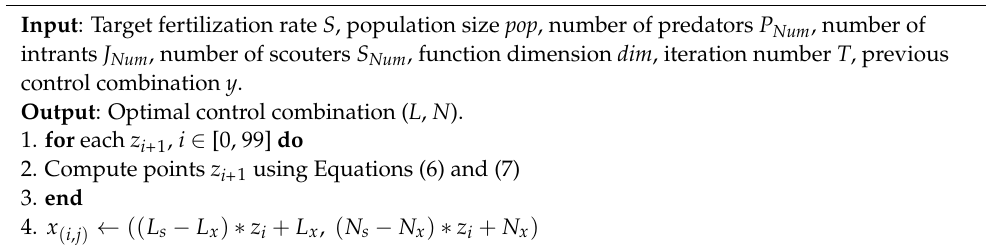
Algorithm 1 Decision-making method of fertilization-rate control using improved